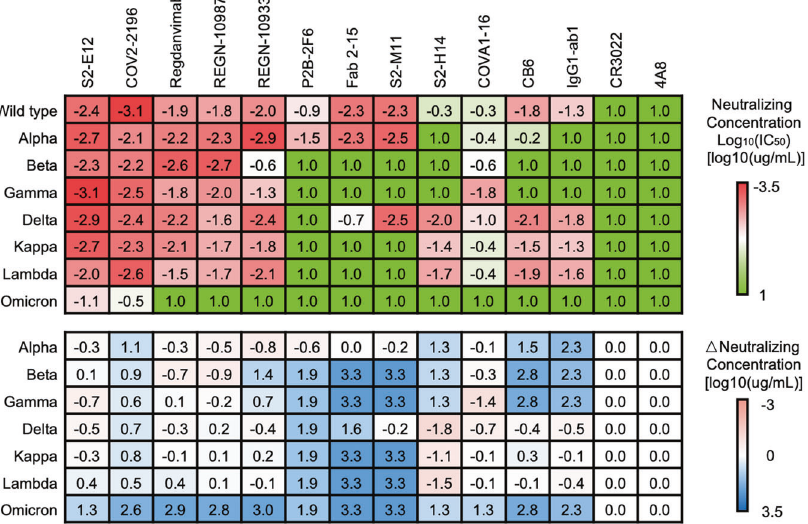
Fig. 4 Immune escape pro fi le of SARS-CoV-2 variants determined by pseudovirus neutralization assay with the indicated antibodies. The antibody neutralization ef fi cacy is presented as a heatmap colored in a red-to-green gradient. The neutralizing concentration log 10 (IC 50 ) [log 10 (µg/mL)] value is listed in the table. A deeper red represents a stronger neutralization ability of the indicated antibody for the pseudovirus expressing the indicated spike protein, and a deeper green represents a lower neutralization ability. The change of neutralization ef fi cacy ( Δ neutralizing concentration) [log 10 (µg/mL)] due to mutations in the spike protein is presented as a heatmap colored in a pink-to-blue gradient. A deeper pink color represents a larger increase in neutralization ability than the wild type, and a deeper blue represents a larger decrease in neutralization ability. The IC 50 values of each antibody toward the indicated pseudoviruses shown in the heatmap are the average results from duplicate